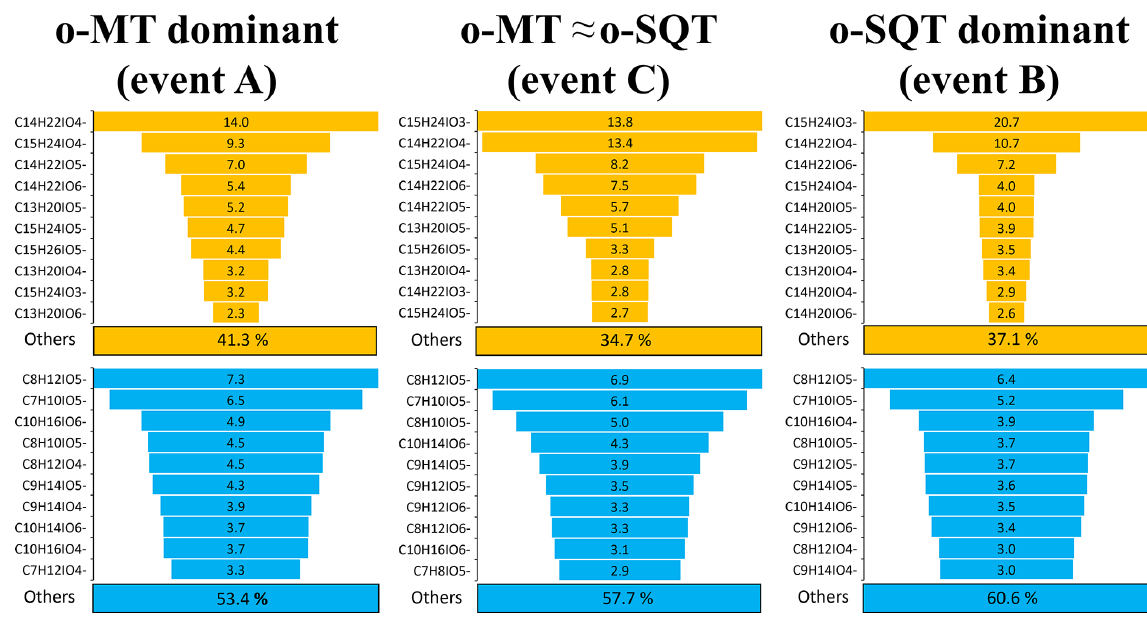
Figure 6. Mass-based contribution of the 10 most abundant chemical compounds (with respective formulas) to all sesquiterpene (o-SQT, upper row) or monoterpene oxidation products (o-MT, lower row), determined by FIGAERO-CIMS, during the studied events (A, B and C) (see Fig. 4). Note that the chemical formulas differ between the events. The percentages below each of the six subplots indicate the mass- based contribution of the remaining sesquiterpene and monoterpene oxidation